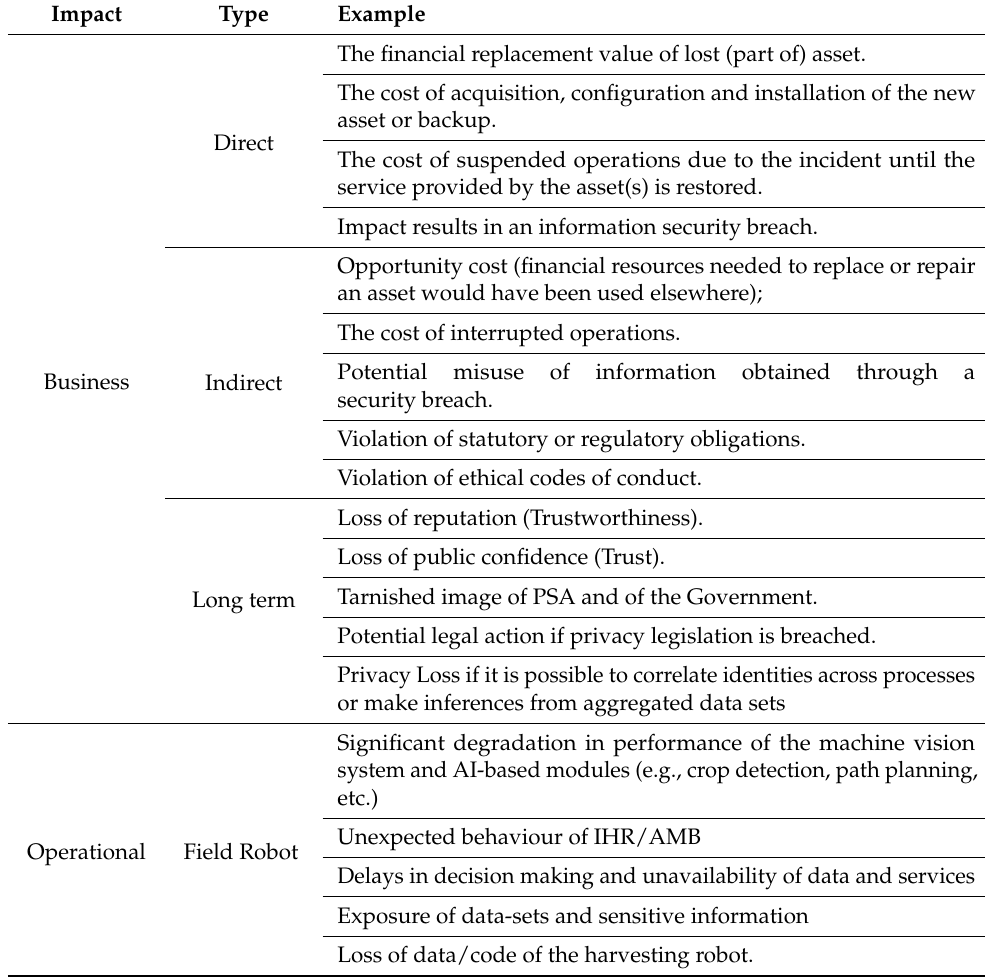
Table 4. Financial and operational impacts of the studied use